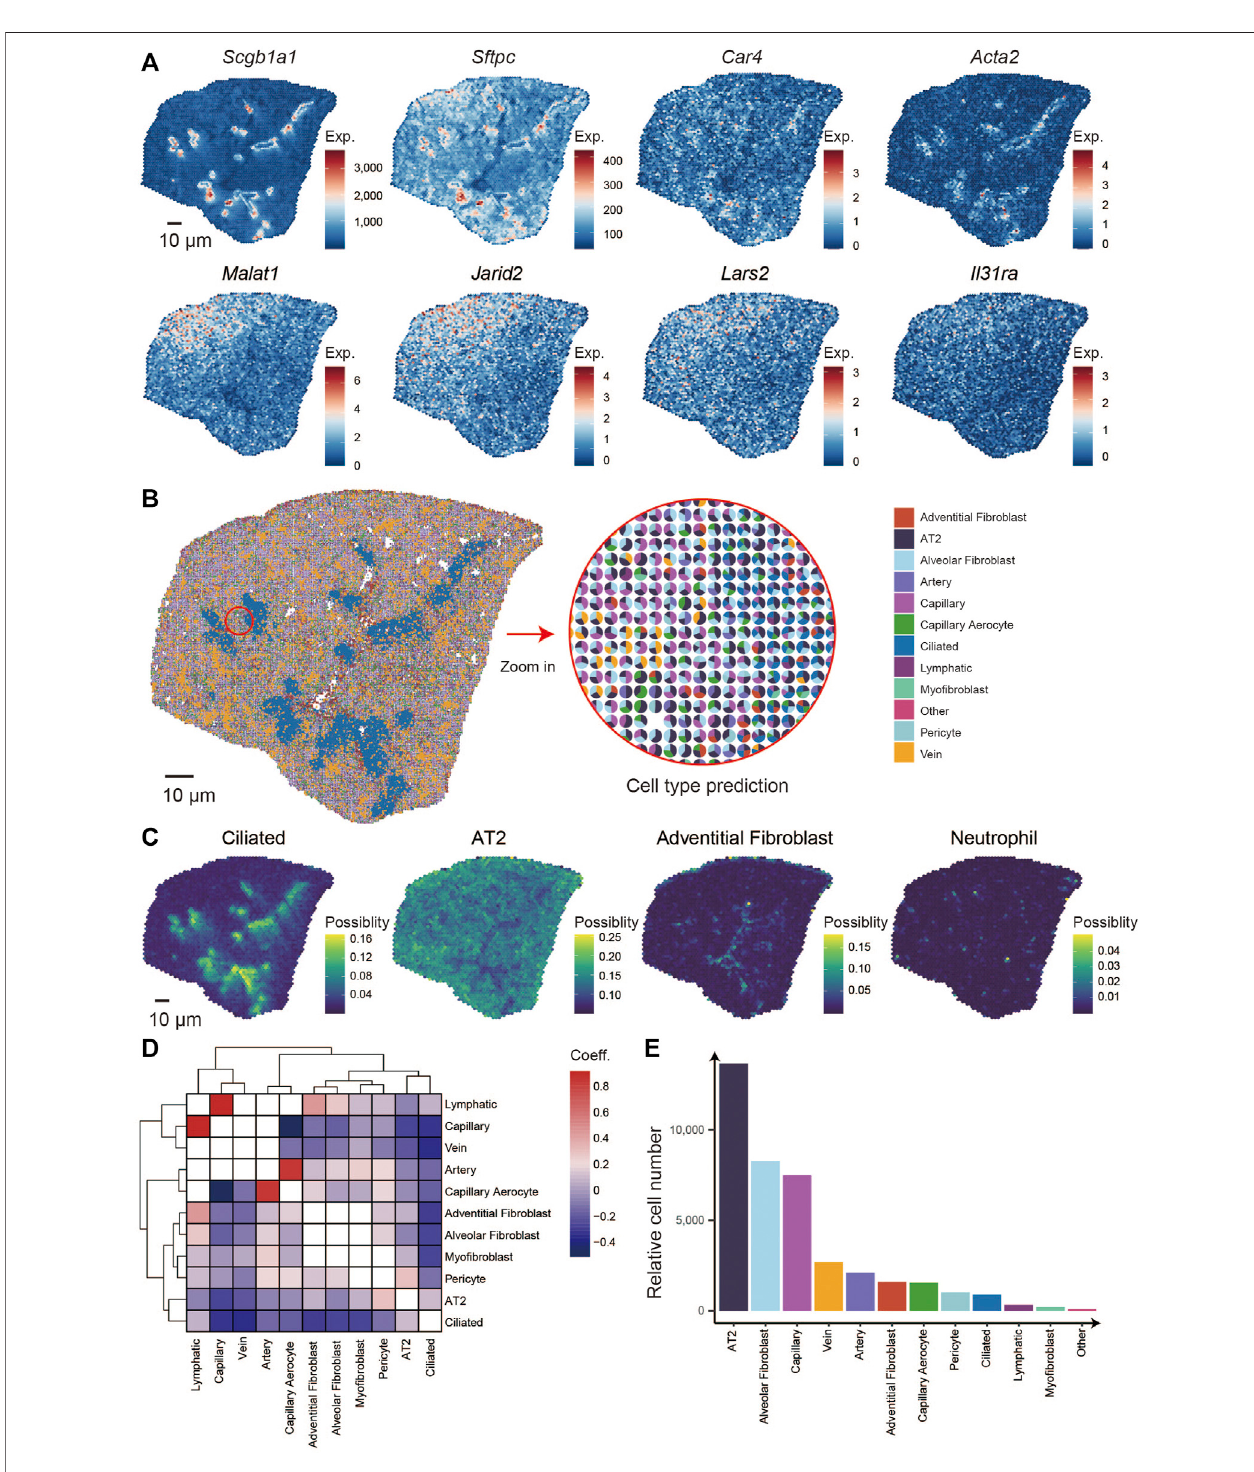
FIGURE 2 | Identi fi cation of the speci fi c pattern of genes in the lung and integrating analysis of scRNA-seq and Stereo-seq. (A) Spatial distribution of genes: Scgb1a1 , Sftpc , Car4 , Acta2 , Malat1 , Jarid2 , Lars2 ,and Il31ra . (B) SpatiallocalizationofmultiplecelltypesinthelungsectioncombinesscRNA-seqandStereo-seq(left) and the percentages of major cell types in each spot (right). (C) Spatial distribution of 4 cell types: ciliated, AT2, adventitial fi broblast, and neutrophil. (D) Spatial location correlation between different cell types. (E) The relative numbers of multiple cell types in the lung section.